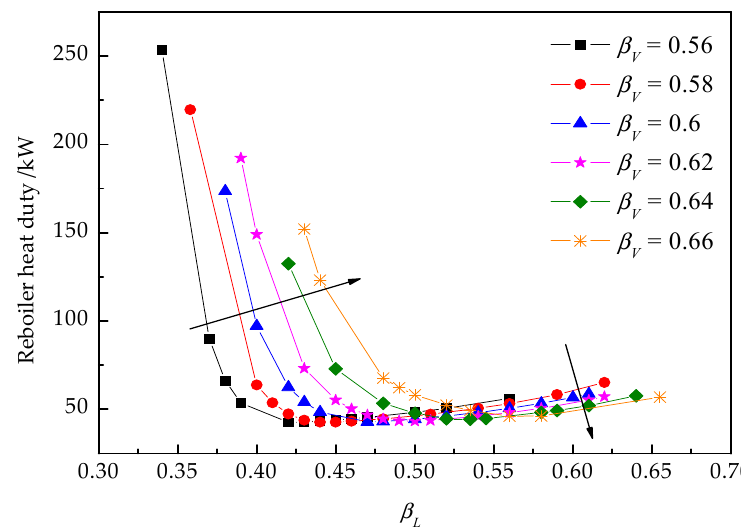
Figure 8. The effect of liquid split ratio on the reboiler heat duty for the case study.